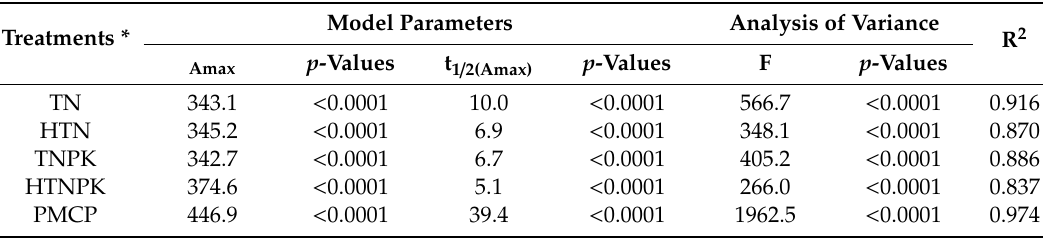
Table 3. Estimation model for NH 4 -N release from di ff erent types of the blended biochar pellet.